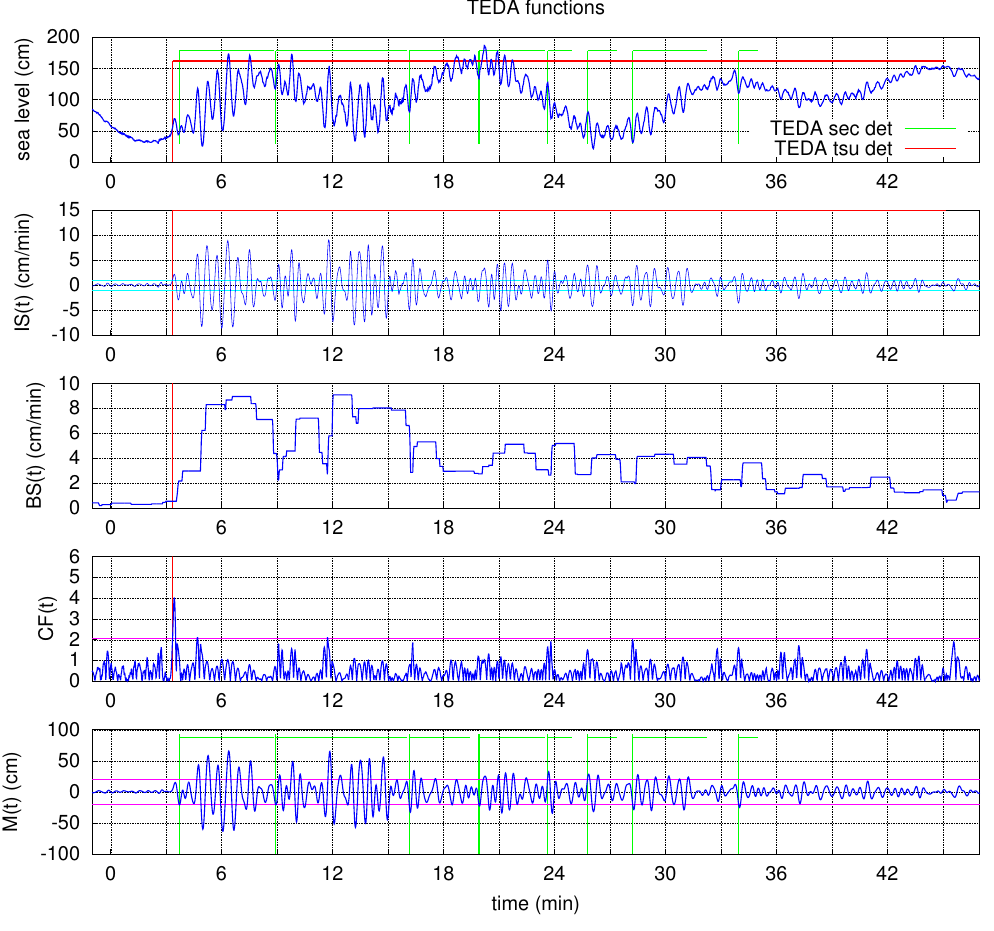
Fig. 6. TEDA functions IS(t), BS(t), CF(t) and M(t) and alerts computed for the sea-level record of Naha, Japan. Original record in the top panel. In the graphs of IS(t), CF(t) and M(t) the respective thresholds λ IS , λ CF and λ SD are plotted as horizontal lines (fuchsia). Vertical lines mark the detection times of tsunami detection (red) and of secure detection (green) methods. Horizontal lines mark the respective tsunami state (red) and alert (green) duration. Notice that tsunami state covers all the tsunami signals until it dies out, while the alert interval has several interruptions. In all plots the time is measured from the origin time of the